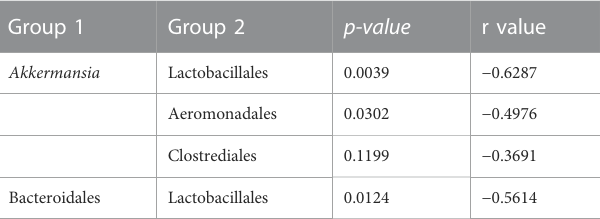
TABLE 1 Spearman Correlation between phylogenetic